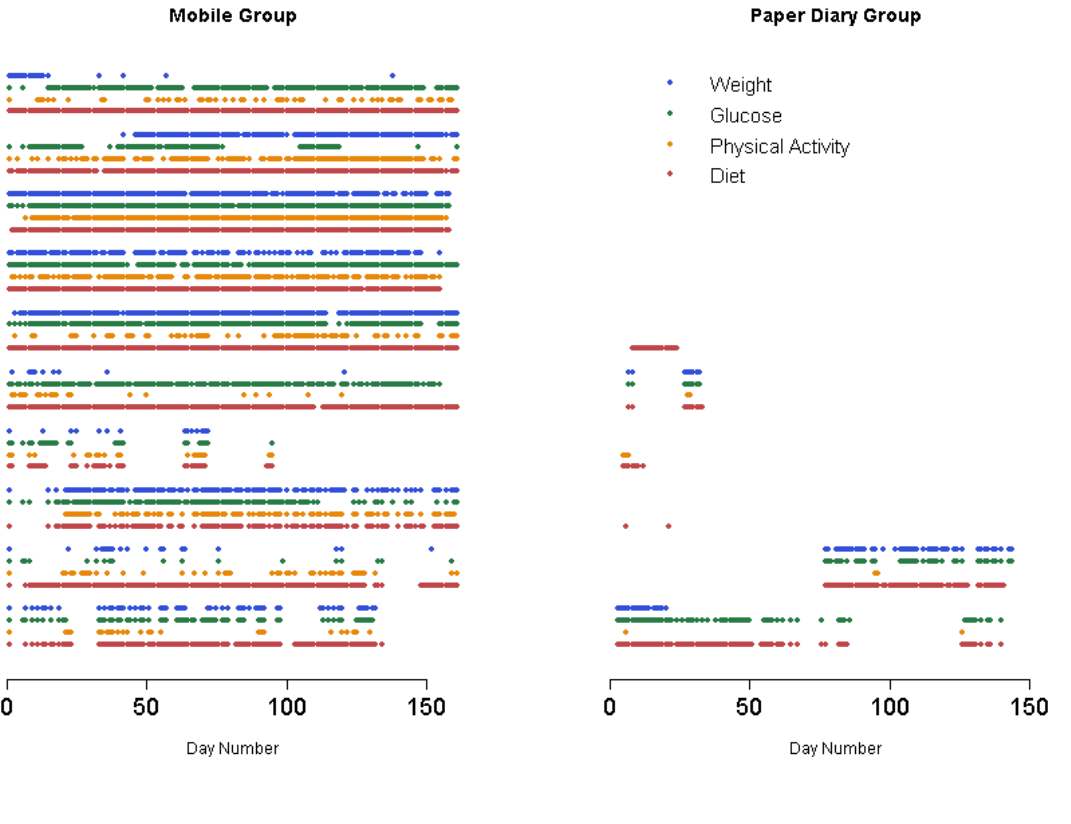
Figure 3. Adherence to self-monitoring of multiple behaviors in the intervention